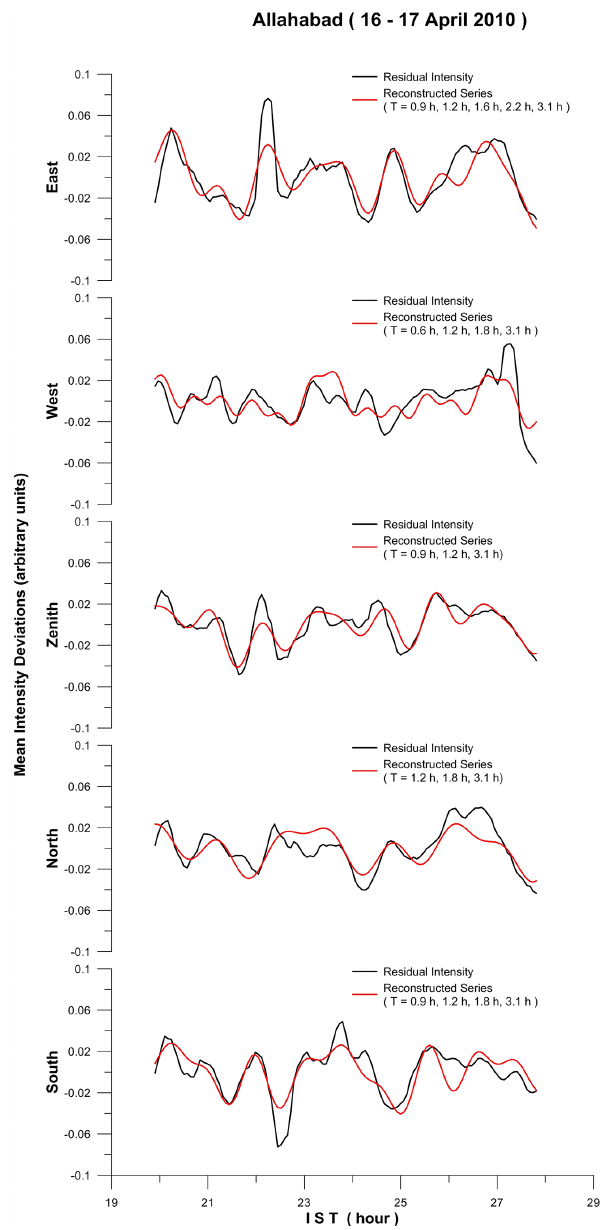
Figure 4. Nocturnal variation of the residual intensity of OH broad- band emission on 16–17 April 2010 along different